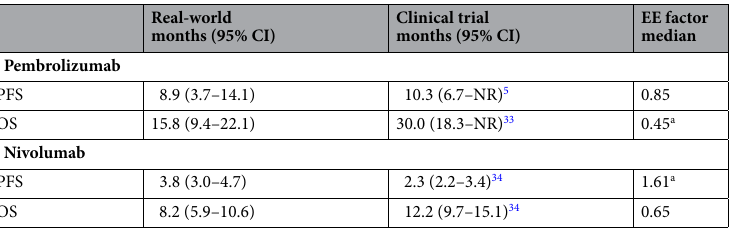
Table 2. Median survival in real-world clinical practice and randomized clinical trials. mPFS, median progression-free survival; mOS, median overall survival; EE factor, efficacy-effectiveness factor. a Significantly different ( p -values < 0.05) from test value 1.00 (one-sample Wilcoxon signed-rank